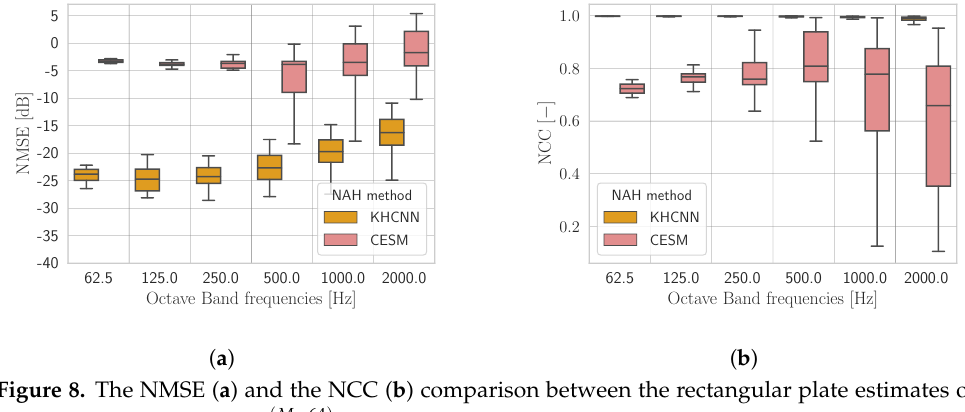
Figure 8. The NMSE ( a ) and the NCC ( b ) comparison between the rectangular plate estimates of KHCNN and CESM from P ( M = 64 ) . H